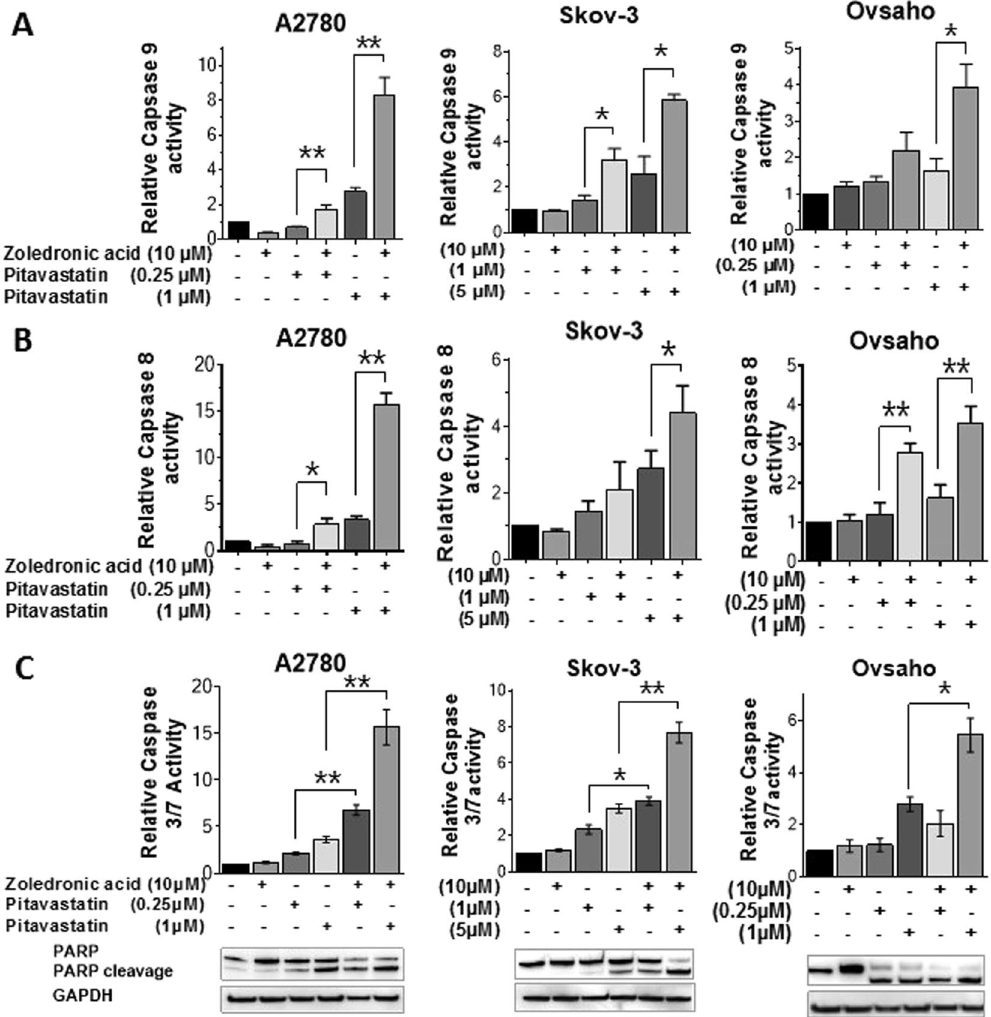
Figure 3. The effect of pitavastatin-zoledronic acid combinations on caspase activity. Caspase 8 ( A ), 9 ( B ), and 3/7 ( C ) activity of A2780, Skov-3 and Ovsaho cell lines were measured by Caspase-Glo assays. Cells were treated with the indicated concentrations of pitavastatin and zoledronic acid for 48 hr. The effect of the drug combinations were significantly different to the effect of pitavastatin alone where shown (mean ± SD; N = 3; * P < 0.05, ** < 0.01; paired t-test). PARP and PARP cleavage ( C ) were measured by western blot analysis (n =